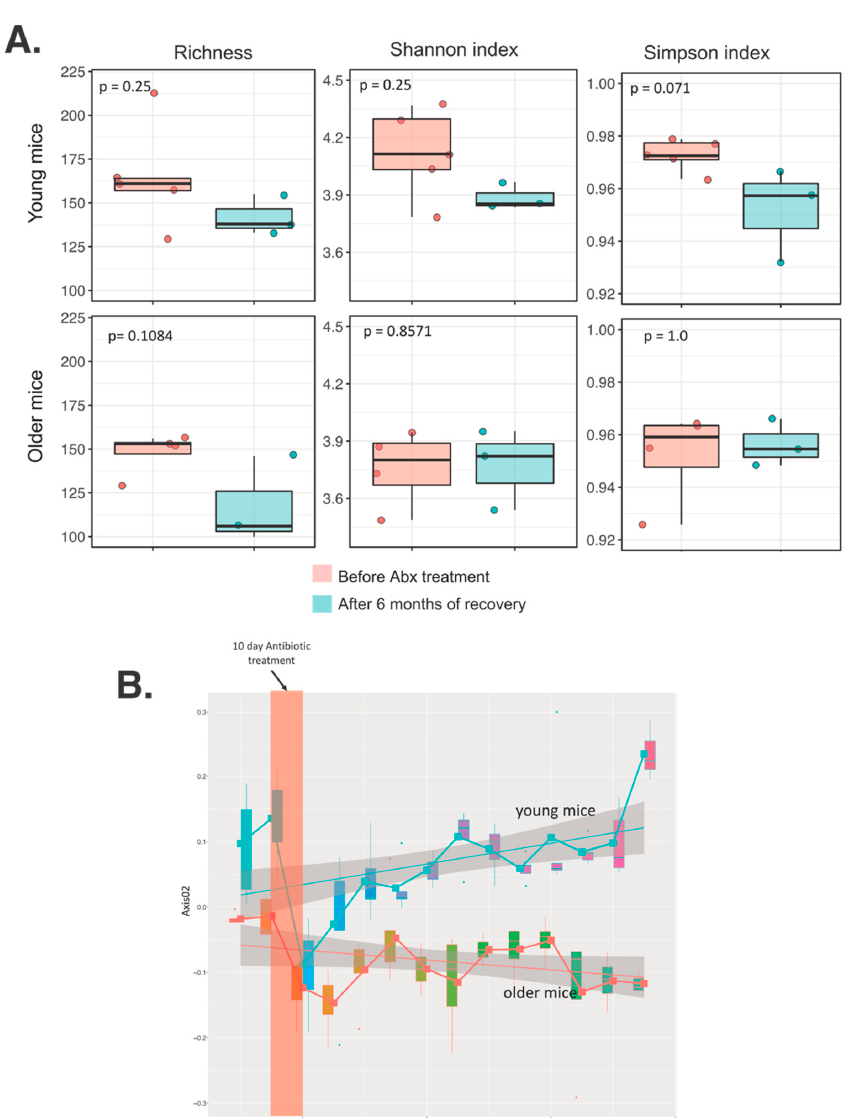
Figure 3. Long-term effect of a single broad-spectrum Abx cocktail treatment on ( A ) alpha diversity indices and ( B ) Bray- Curtis dissimilarity in gut microbiota of young and older